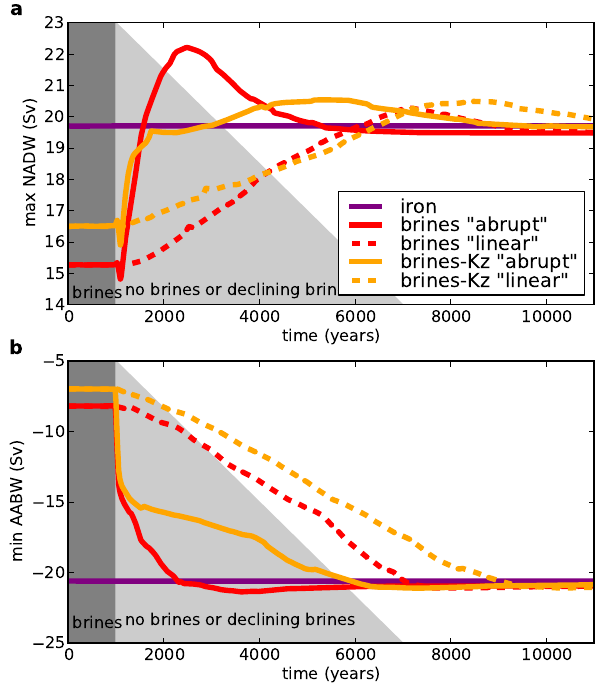
Fig. 5. Evolution of the thermohaline circulation with a constant climate. (a) Evolution of the maximum value of the North Atlantic stream function (Sv) and (b) evolution of the minimum value of the Southern Ocean stream function